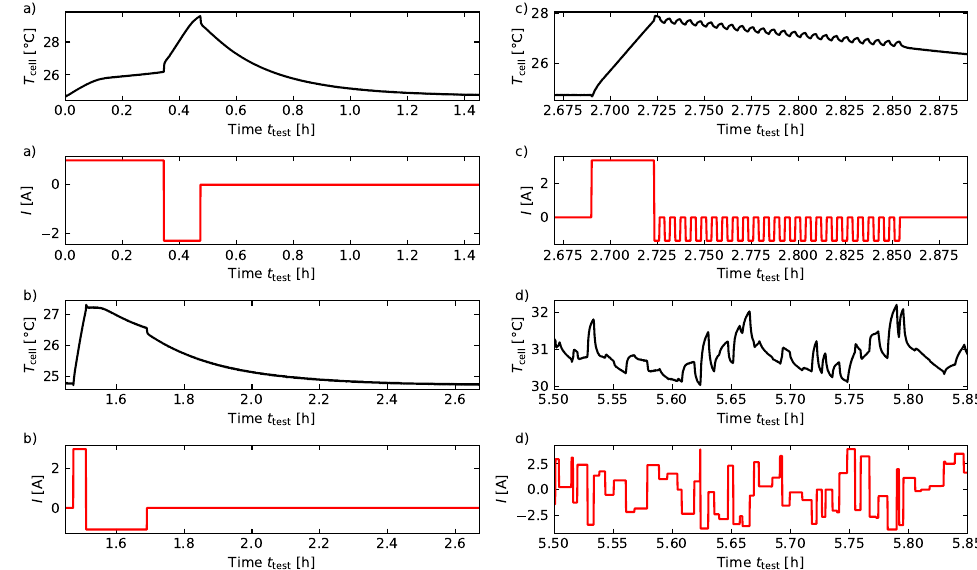
Figure 6. Enlarged view of the areas marked in Figure 5. Presented are temperature response T cell ( t test ) and current profile I ( t test ) of each of the marked ares ( a – d